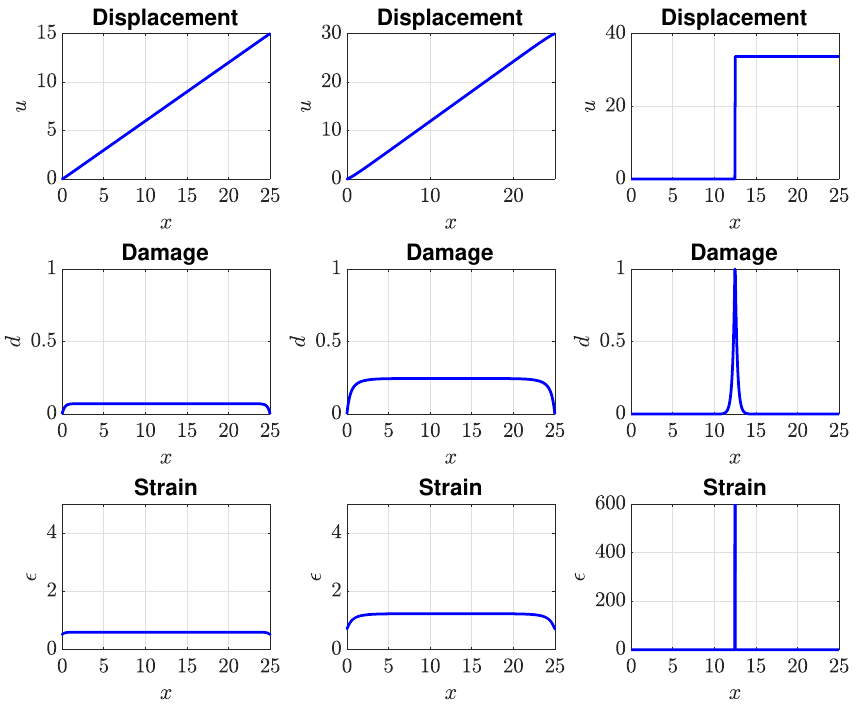
Figure 6. Evolution of the displacement, damage, and strain field for µ (middle), 90% u max